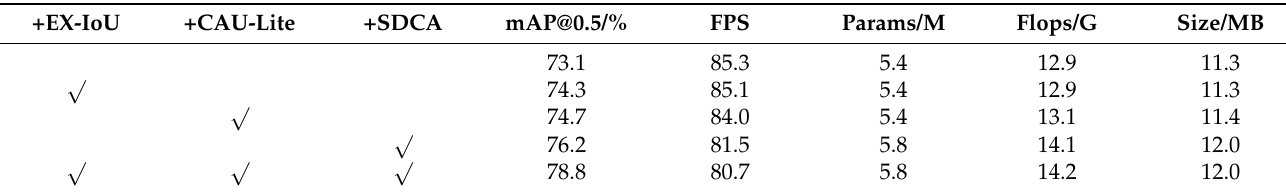
Table 2. Ablation Table 2. Ablation experiments.